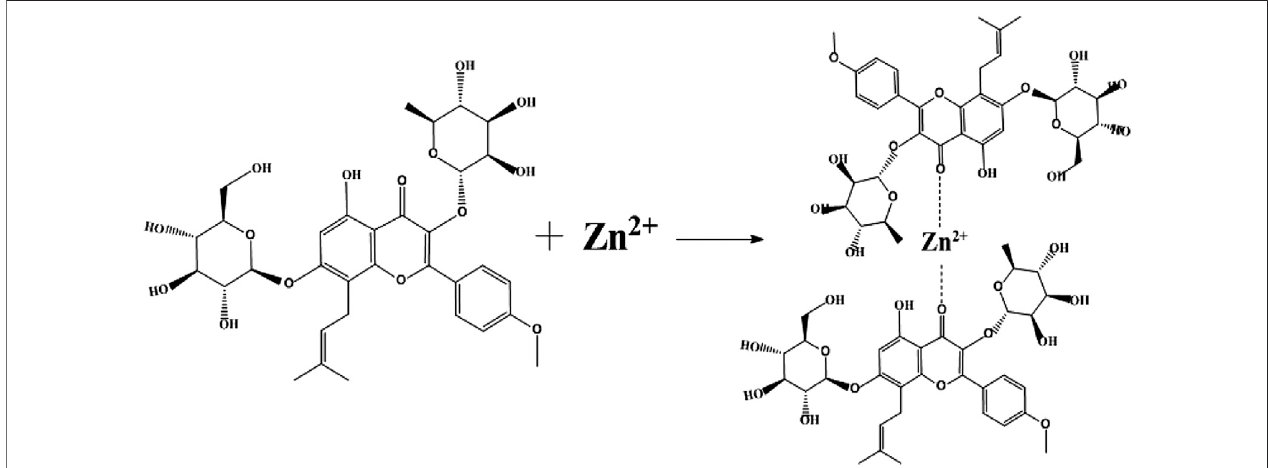
FIGURE 1 | Chemical Synthesis Route of the Icariin-Zinc complex.